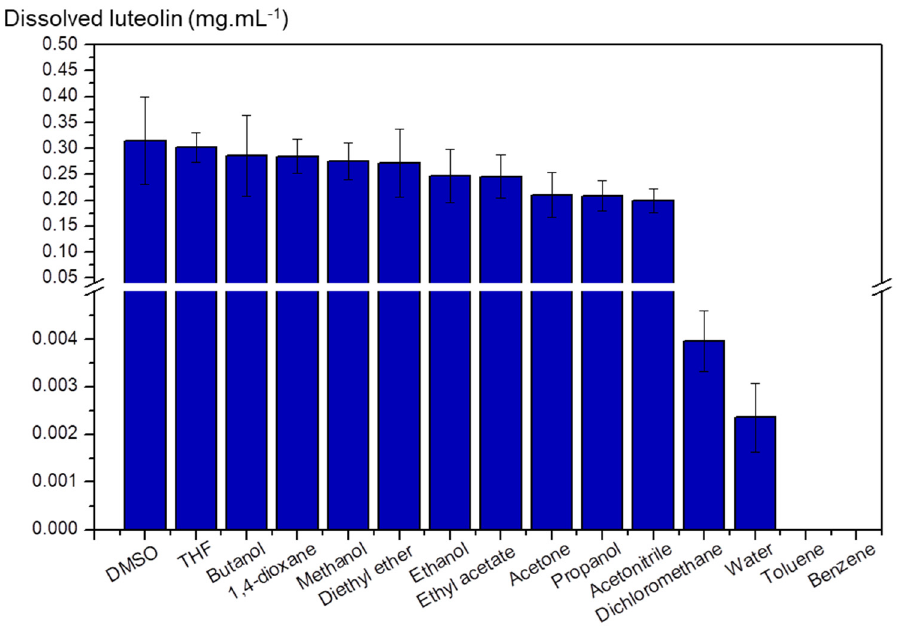
Figure 5. Values of luteolin solubility in a systematic series of solvents, at 27 °C.